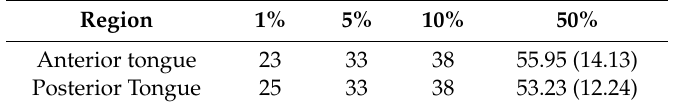
Table 4. Normal values of tongue strength